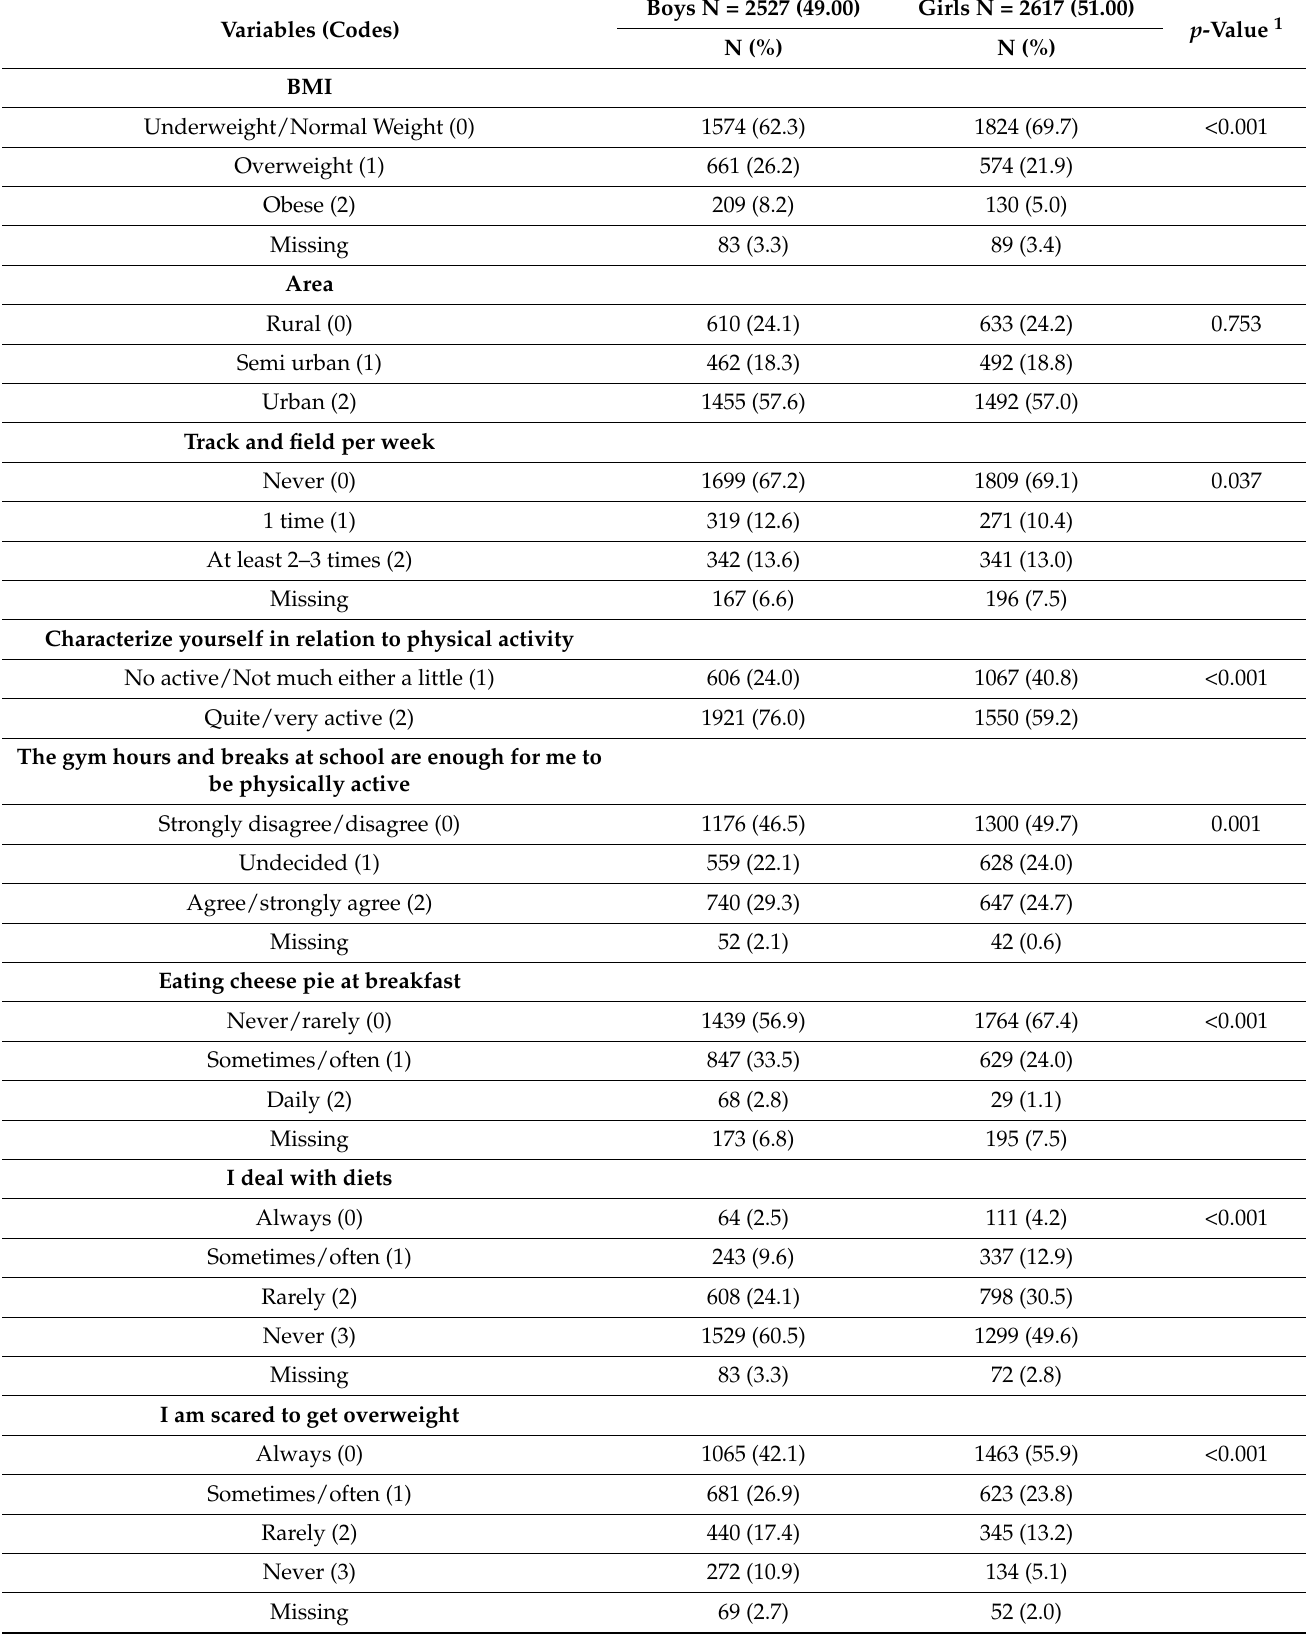
Table A3. Descriptive statistics and statistical tests ( α = 5%) by sex, for significant variables on multivariate